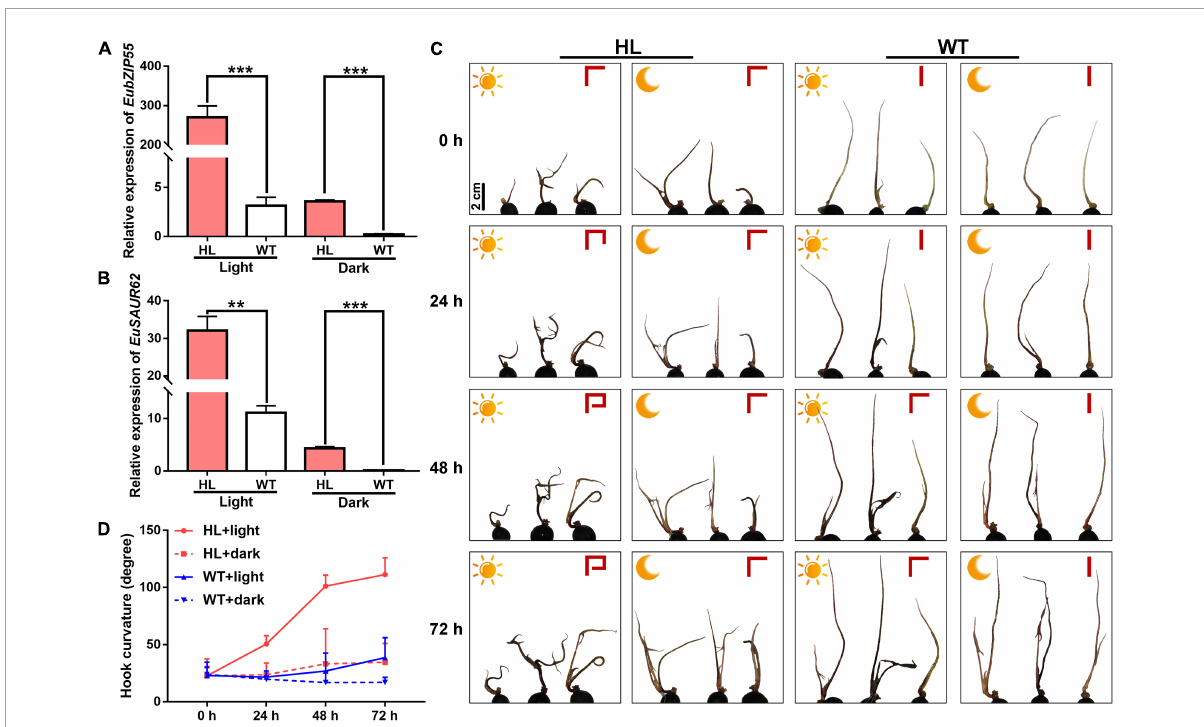
FIGURE8 Functional characterization of EubZIP55 on the auxin-mediated apical hook of Euryale seedlings. Relative expression of EubZIP55 (A) and EuSAUR62 (B) in seedlings of WT and HL under constant light or dark conditions. (C) Phenotypes of apical curvature in the 2-week-old seedlings of WT and HL under constant light or dark conditions. The sun represents constant light treatment, and the moon represents dark treatment. Curvature degree is shown as a perpendicular line in the upper right of each picture. Scale bar = 2 cm. (D) The quantitative assessment of apical curvature of seedlings. Two-tail Student’s t -test was used for statistical analysis; Data are mean ± SD. ** p < 0.01, *** p <